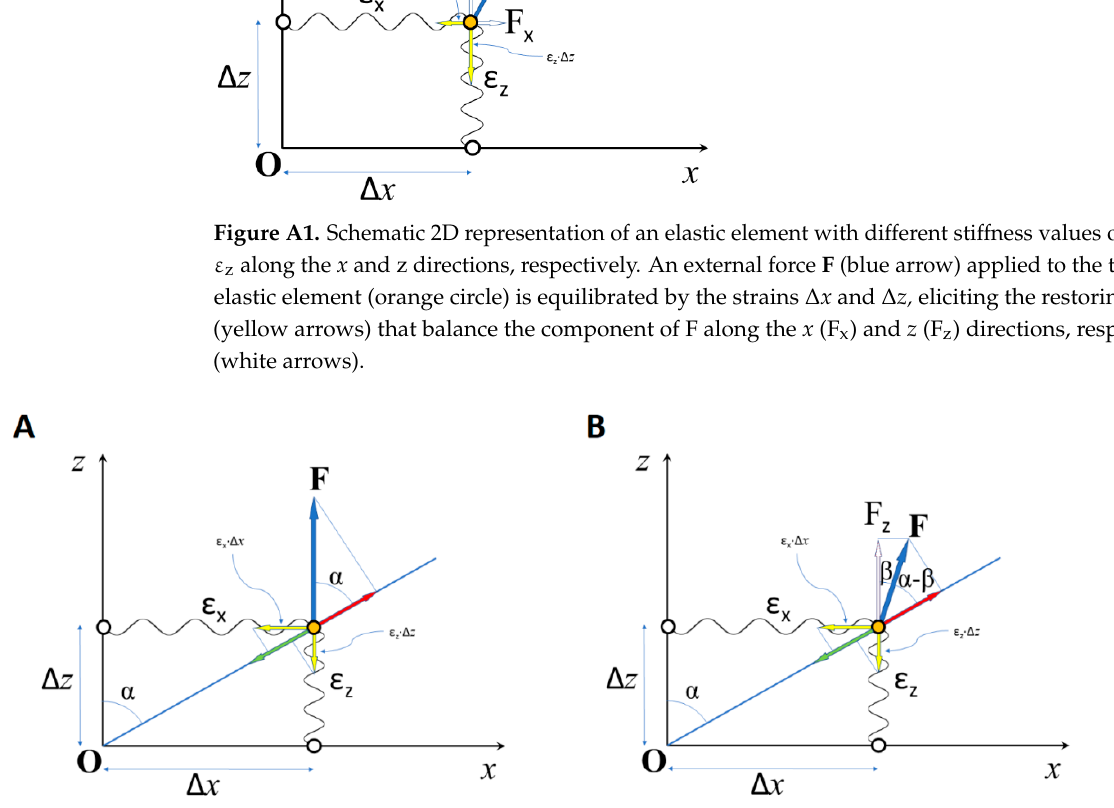
Figure A1. Schematic 2D representation of an elastic element with different stiffness values of ε x and ε z along the x and z directions, respectively. An external force F (blue arrow) applied to the tip of the elastic element (orange circle) is equilibrated by the strains Δ x and Δ z, eliciting the restoring forces (yellow arrows) that balance the component of F along the x (F x ) and z (F z ) directions, respec- tively (white arrows).